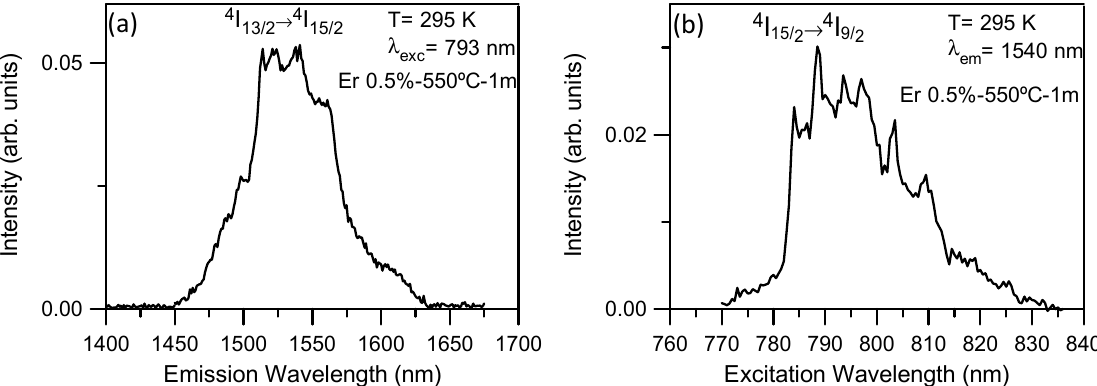
Figure 9. ( a ) Room temperature emission spectrum of 80SiO 2 -20LaF 3 -0.5Er 3+ (TEOS-MTES) bulk sample heat treated at 550 ° C for 1 min obtained on exciting at 793 nm. ( b ) Low-temperature excitation spectrum obtained at 1540 nm.